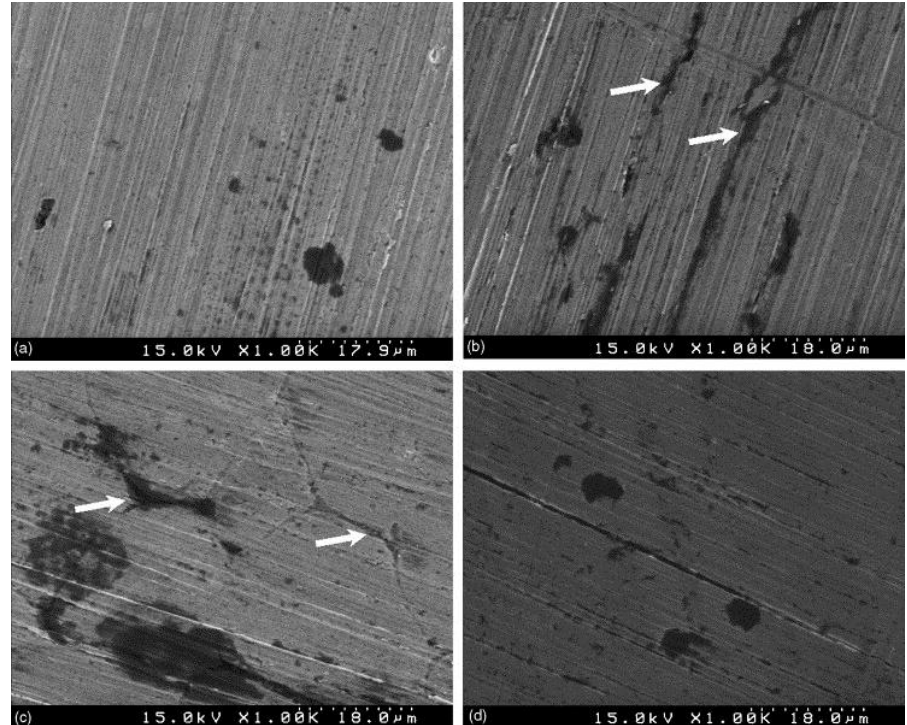
Figure 2. The surface appearance of alloys after immersion tests in the 3.5 wt % NaCl solution for 30 days: ( a ) FeCoNiCr; ( b ) FeCoNiCrCu 0.5 ; ( c ) FeCoNiCrCu; and ( d ) 304 L (white arrows point to the localized corrosion caused by electrochemical attack along the interdendrites) [44] (Reprinted with permission from Elsevier).